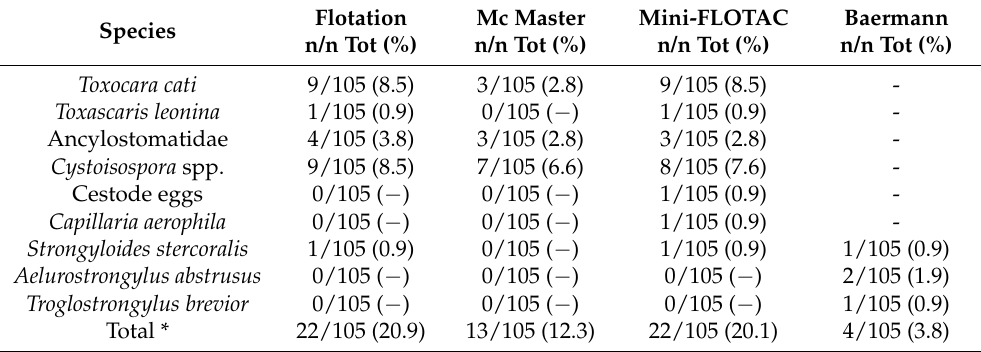
Table 6. Number (n) and percentage (%) of cat samples that scored positive using each technique compared to the overall number of samples (n